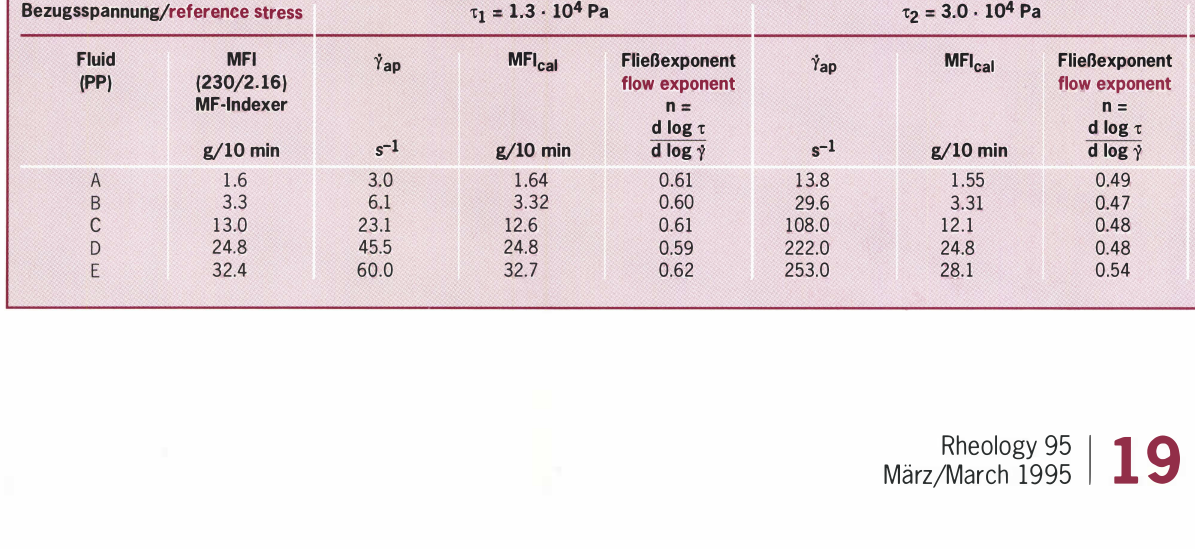
Tabelle 1: Schmelzindexwerte MFI